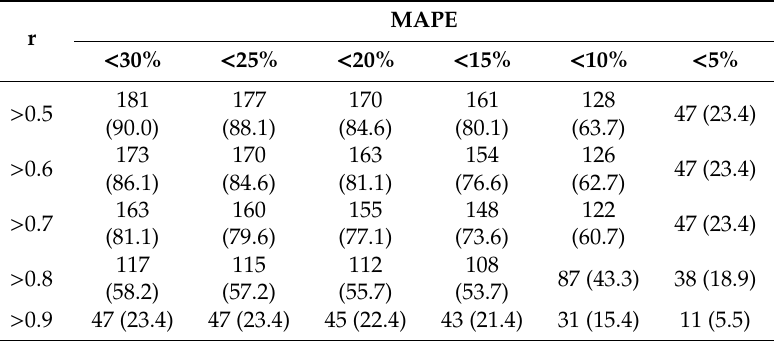
Table 2. The number and percentage of individual buildings with mean absolute percentage error (MAPE) lower than 30% and Pearson correlation coe ffi cient (r) greater than 0.5 for the 48-h heat demand